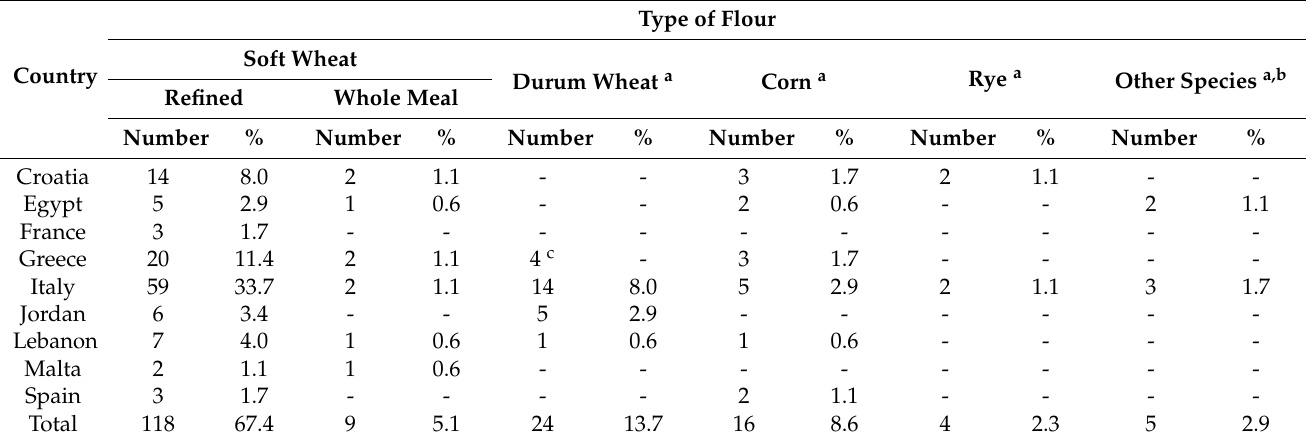
Table 2. Type of flour used in the preparation of flat breads. Multiple answers were admitted, because breads could be prepared with different flours or with flour